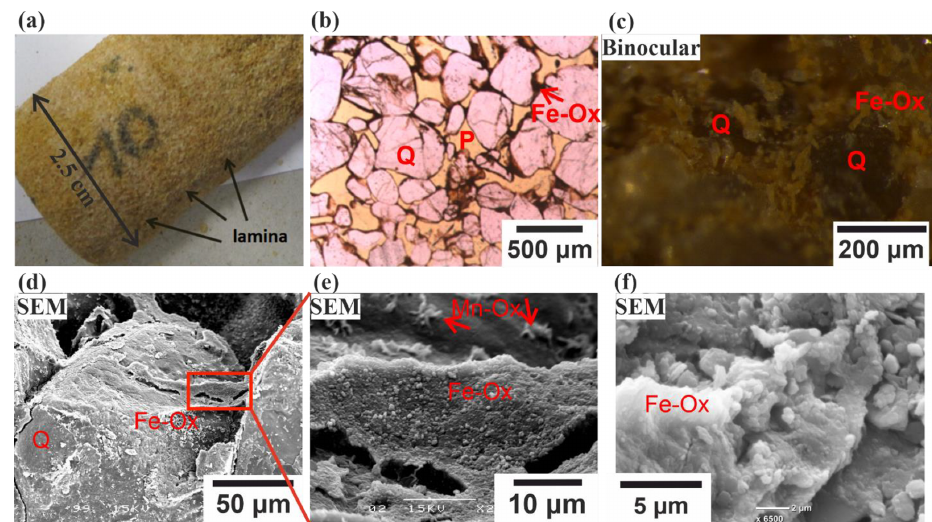
Figure 3. Representative images of sandstone S1. (a) Darker laminae in the x – y plane at the millimetre scale are observed. (b) Thin-section image of S1, P refers to open pores, Q to quartz, Ox to oxide. (c) FeOx flakes (yellow) on quartz grains (pale grey). (d) SEM image of S1: grain-coating, meniscus-bridging cement and overgrowth of FeOx flakes. (e, f) Magnified images at different scales.